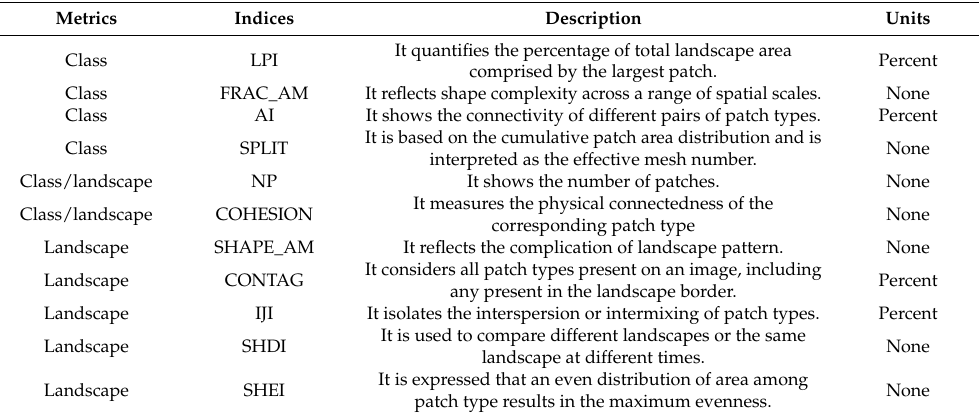
Table 1. Indices on class- or landscape-level